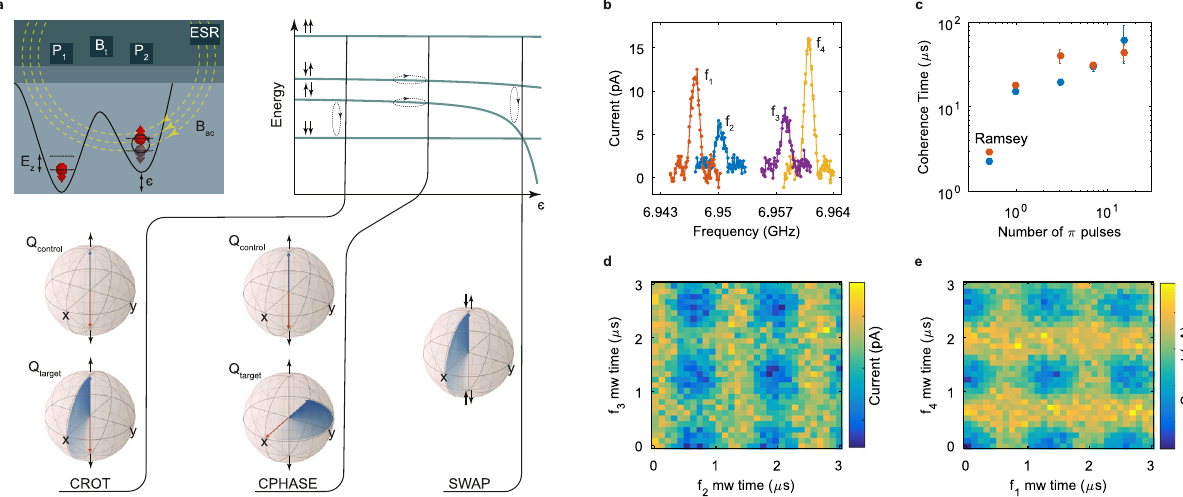
Fig. 1 Two-qubit gates and quantum coherence of silicon spin qubits operated at a T = 1.05 K. a Schematic representation of the double quantum dot system. The device is the same as used in ref. 19 . Two plunger gates ( P 1 and P 2 ) and one barrier gate ( B t ) are used to control the detuning energy ϵ and the tunnel coupling t between the quantum dots. Spin manipulation occurs via electron-spin-resonance (ESR) using an on-chip microwave line. The energy diagram displays the four electron spin states as a function of ϵ . We exploit both driven rotations and pulsed exchange for coherent control. Controlled rotations (CROTs) can in principle be executed at all points where J ≠ 0, given that gate times are appropriately set. CPHASE gates are conveniently executed when the exchange interaction is much smaller than the Zeeman energy difference between the qubits, while SWAP oscillations can be realized when the exchange interaction is much larger. b Using ESR control we fi nd the four resonance frequencies of the two-qubit system. Here, the exchange interaction is tuned to 3 MHz. The spectrum is composed of the frequencies: f 1 ( "# (cid:1) (cid:1) (cid:3) (cid:3) (cid:1) (cid:1) (cid:2)! "" ( "# ). c Coherence times as a function of the number of refocusing π pulses. Here, the exchange is set to 2 MHz. The plot includes the dephasing times measured through a Ramsey experiment to allow comparison. d , e Realization of CROT operations. Rabi oscillations of the target qubit are controlled by the spin state of the control qubit. We fi nd controlled rotations on all the four resonance frequencies f 1 , f 2 , f 3 , f 4